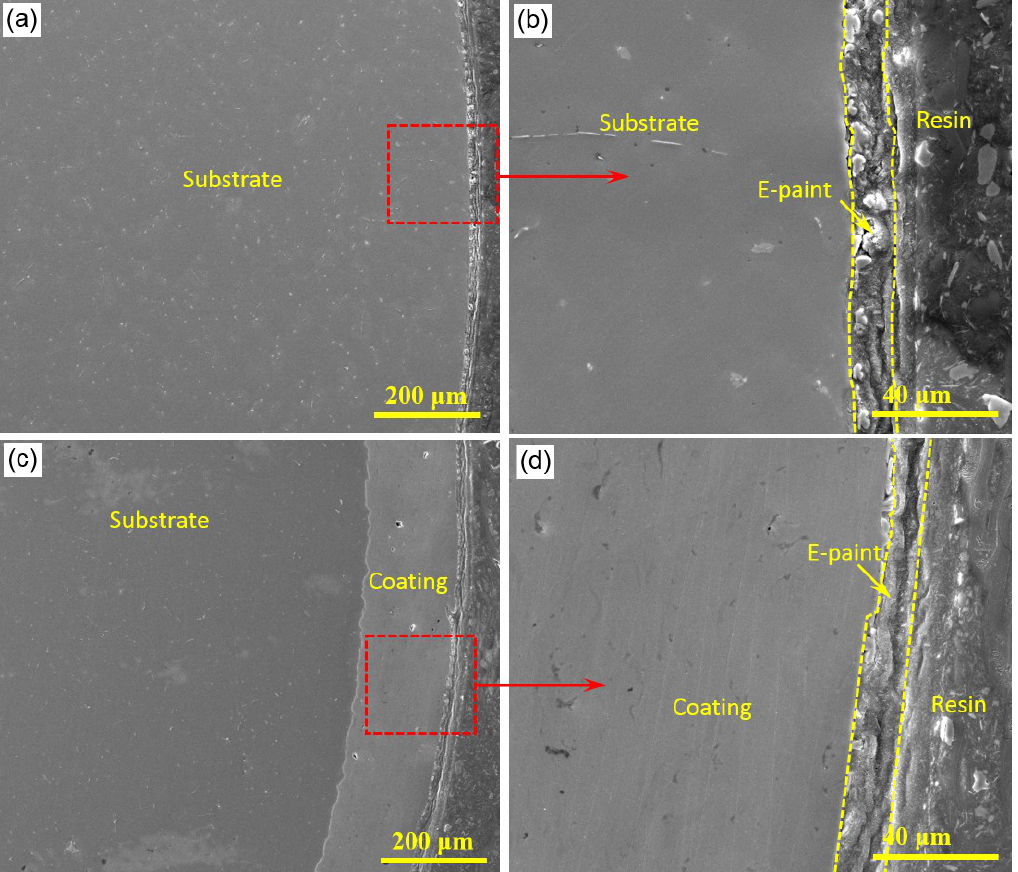
Figure 3. Scanning electron microscopy (SEM) images show the polish-cross section of AZ31B Mg alloy with ( a , b ) e-painted on AZ31B and ( c , d ) e-painted on cold spray AA7075.